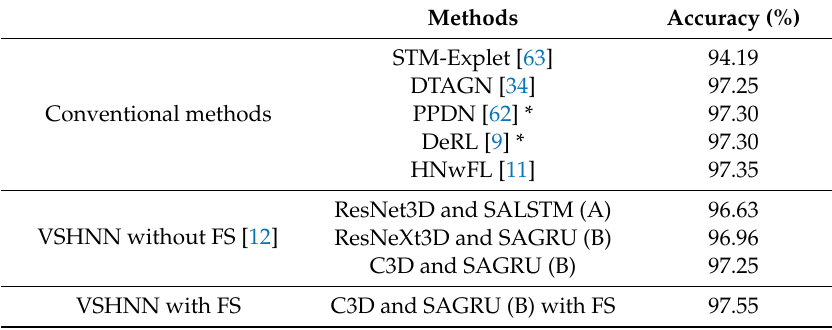
Table 5. Comparison of average accuracy for CK + dataset. The letters in parentheses indicate the types of SARNN. VSHNN without the FS module corresponds to [12]. * Indicates a method using only image information.